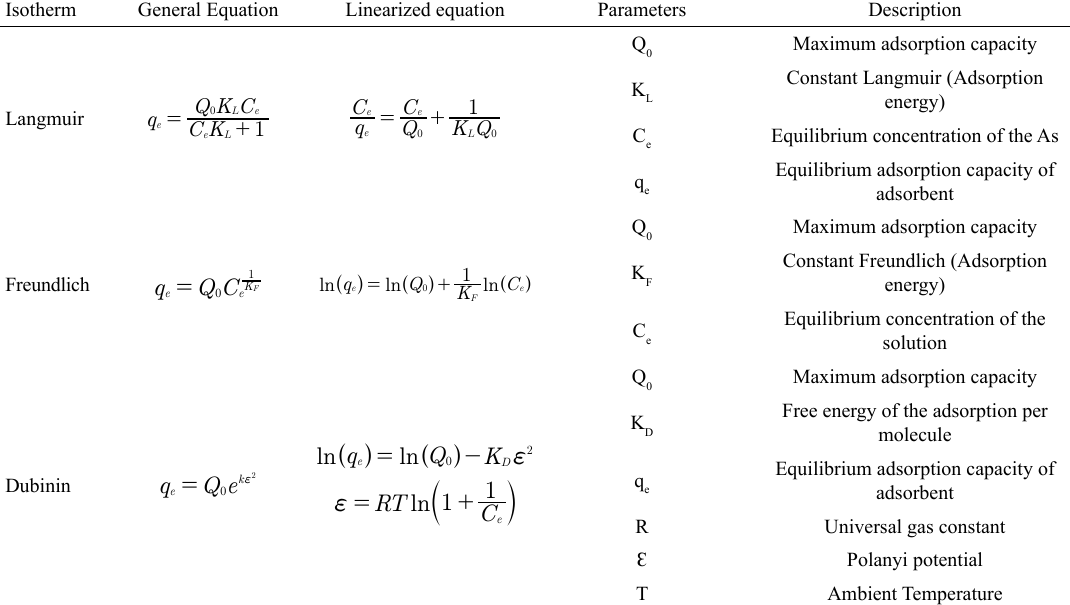
Table 1: Models and parameters employed for fitting the adsorption isotherms in the equilibrium. Isotherm General